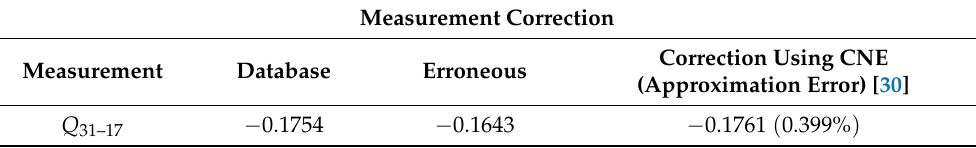
Table 6. Corrected measurement using the